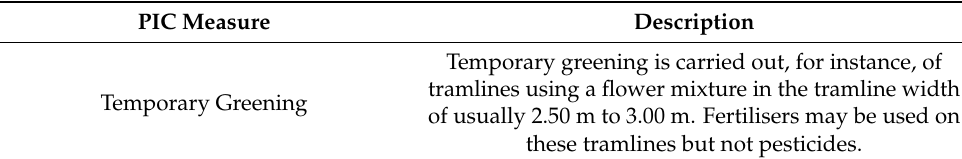
Table 1. Overview of the selected PIC measures and their